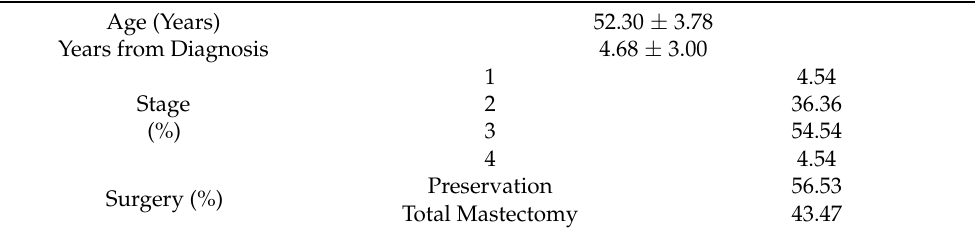
Table 1. Characteristics of the breast cancer survivor